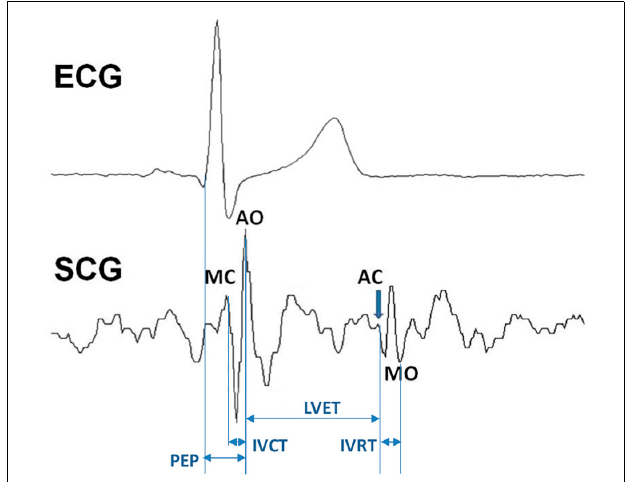
FIGURE 1 | The seismocardiogram (SCG) signal, the localization of the fiducial points associated with the opening and closure of the aortic and mitral valve, its relation with the ECG waveform, and the schematization of how cardiac time intervals are derived. See text for abbreviations.